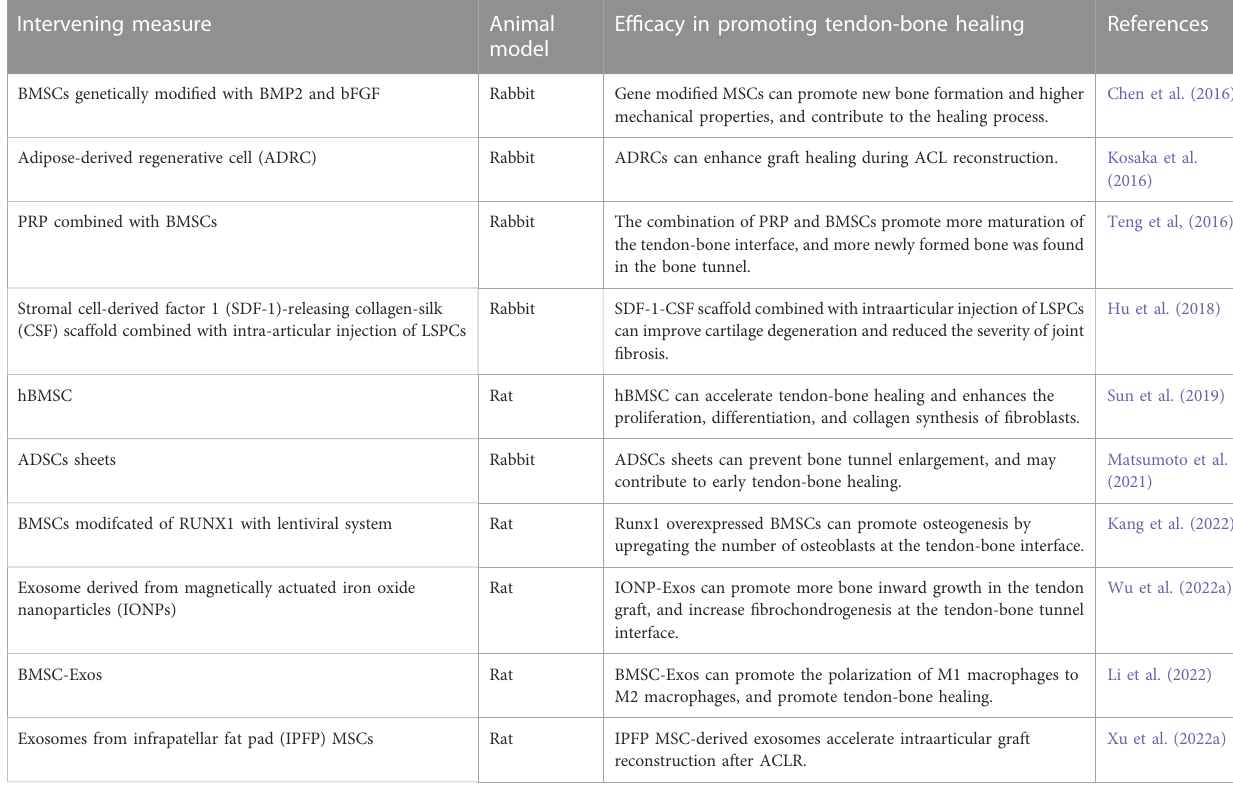
TABLE 3 Preclinical studies of stem cells in promoting tendon-bone healing in ACL reconstruction. Intervening